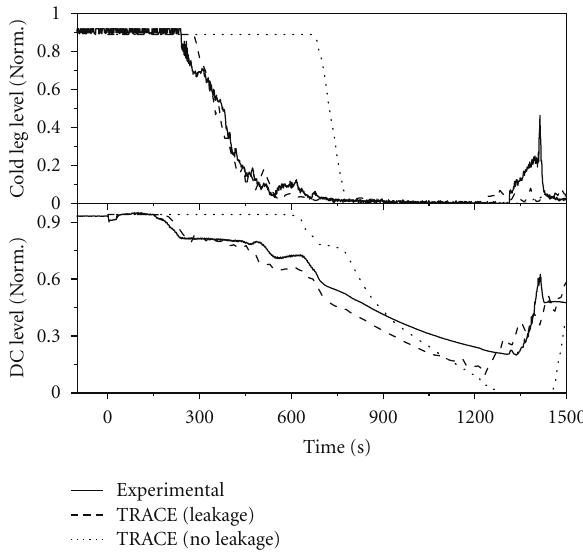
Figure 8: Collapsed water levels of the DC and the cold leg for Test 6-1 with and without a leakage between the UP and the